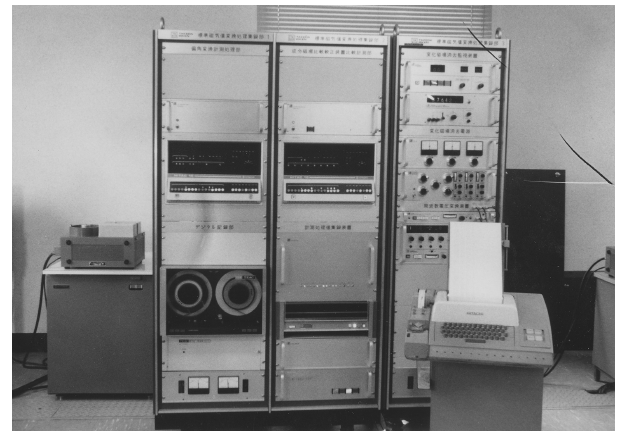
Figure 26. The computing unit of KASMMER (photo supplied by Kakioka Magnetic